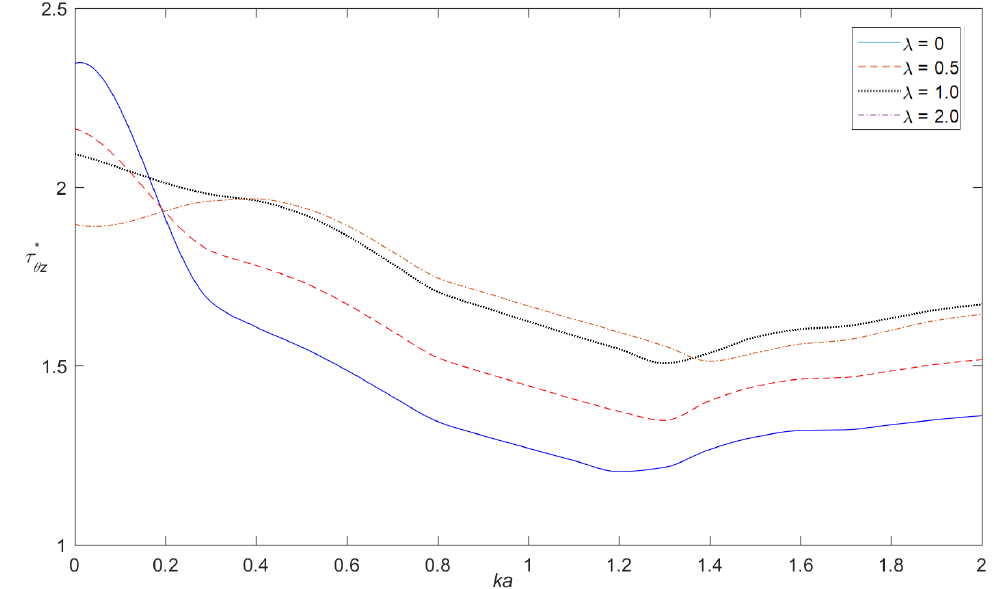
Figure 8. Dynamic stress concentration factor versus incident wave number in piezomagnetic com- posites with double openings ( / d a  2.1,  = ( 0, 0.5, 1.0,